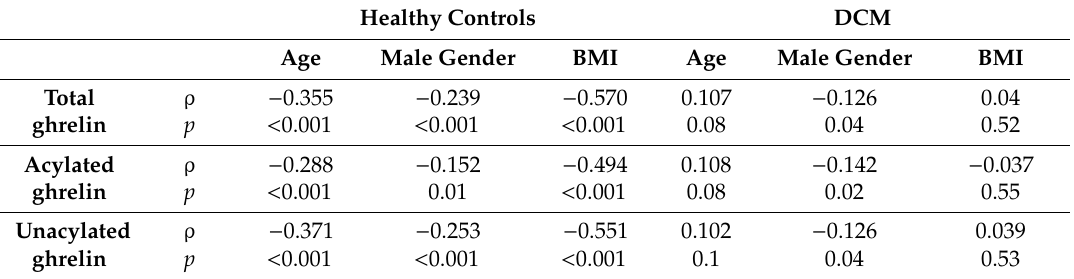
Table 2. Correlations in healthy controls and in patients with